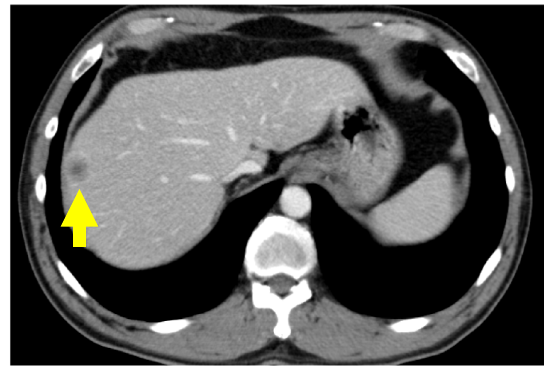
Fig. 1 Contrast-enhanced CT. Contrast-enhanced CT showed a ring-enhanced tumor in the right hepatic lobe (arrow)